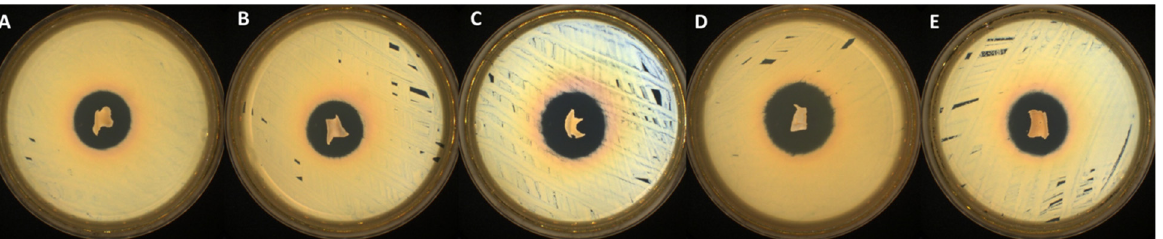
Figure 4. Antibacterial activity of the tested samples: ( A ) PVA_PEBSA 25/75 _Thy_ α -Tcp, ( B )